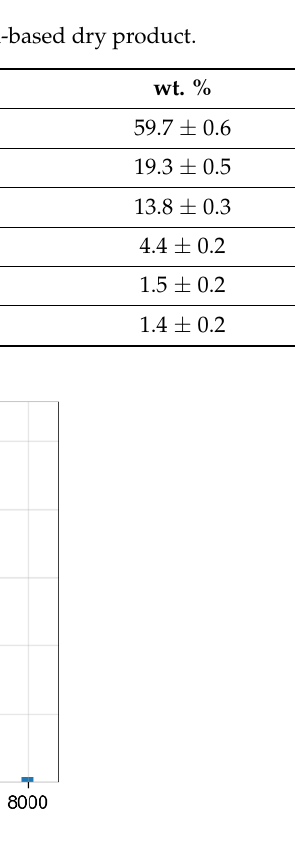
Figure 33. Granularity of ready mixed earth-based dry product.